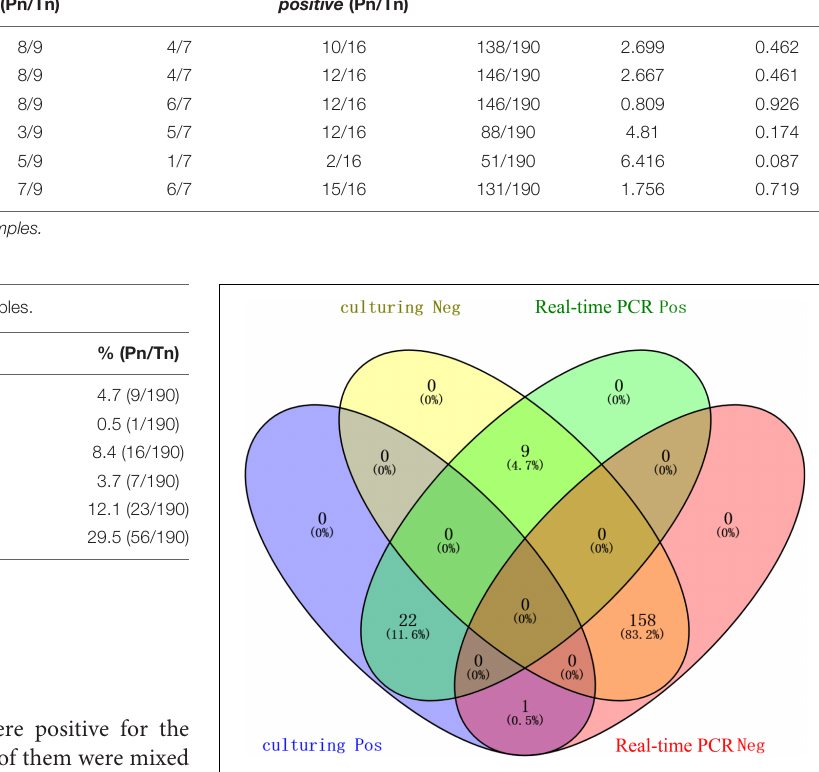
FIGURE 1 | Venn-diagram summarizing the results of the culturing and the multiple real-time PCR detection method. The numbers in blue modules represent the number of culturing positive samples. The numbers in light yellow modules represent the number of culturing negative samples. The numbers in pink modules represent the number of real-time PCR negative samples. The numbers in green modules represent the number of real-time PCR positive